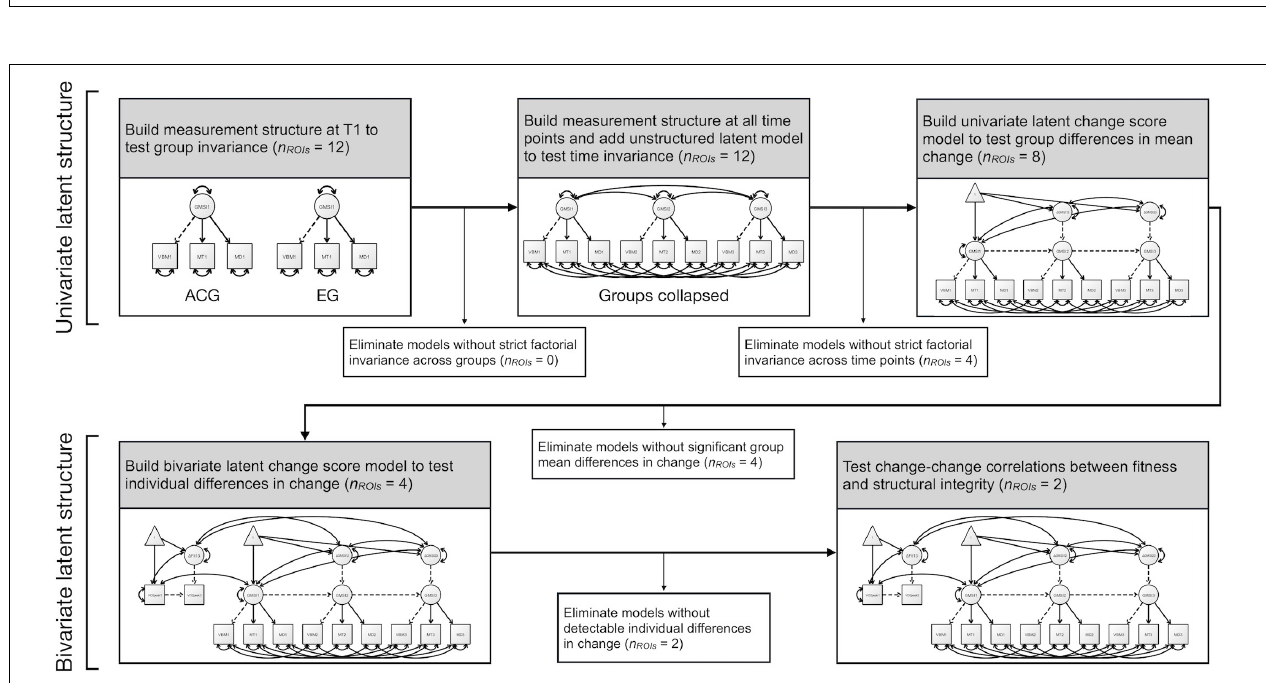
FIGURE 2 | Flowchart of the analysis plan of gray-matter structural integrity models including factorial invariance testing across groups and time points, testing for group mean differences in change, testing for significant individual differences in change, and testing for change-change correlations with fitness. T1, time point 1 (0 months). Model paths intentionally unlabeled for visual clarity. Dashed lines represent paths fixed to 1. See Figure 1 for further model details.